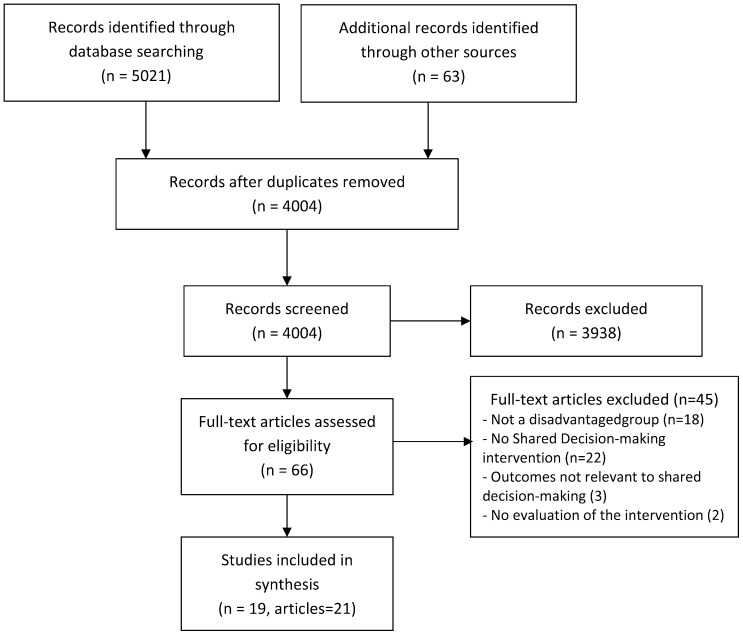
Prisma flow diagram.